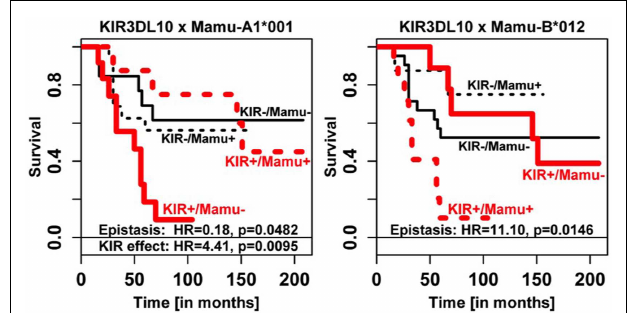
FIGURE 6 | Epistasis of Mamu-A1*001 and Mamu-B*012 with KIR3DL10 on survival time .The data for KIR3DS05 are highly similar and are, therefore, not shown. Epistasis effect estimates on survival were consistent for KIR3DL10 (see figure) and KIR3DS05 ( KIR3DS05 × Mamu-A1*001 : detrimental KIR effect HR 4.32, p = 0.0102, and epistasis HR 0.20, p = 0.0532; KIR3DS05 × Mamu-B*012 : epistasis HR 6.35, p = 0.0535).The more frequent KIR3DL10 had higher statistical